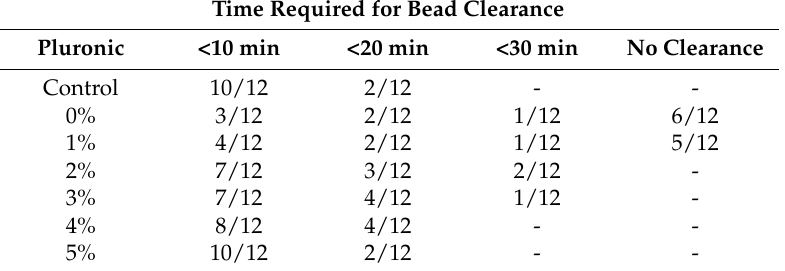
Table 2. Number of explants (out of 12) clearing beads during the indicated amount of time after incubation with CSA-131 (100 µ g/mL) for 1 h. The control was not treated with CSA-131. Indicated amounts of pluronic were used with